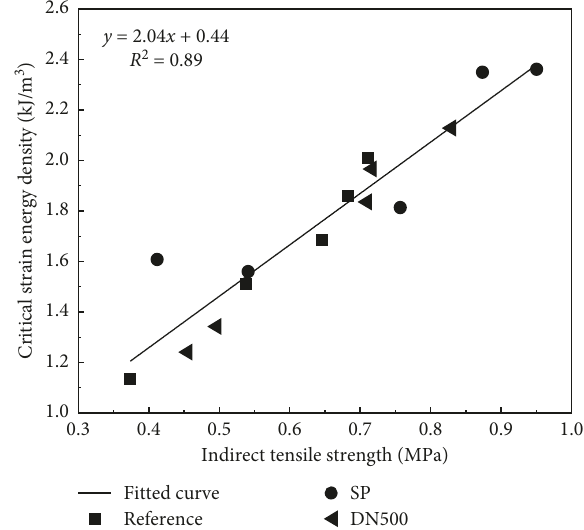
Figure 11: Relationship between stiffness modulus and ITS with different surfactants.